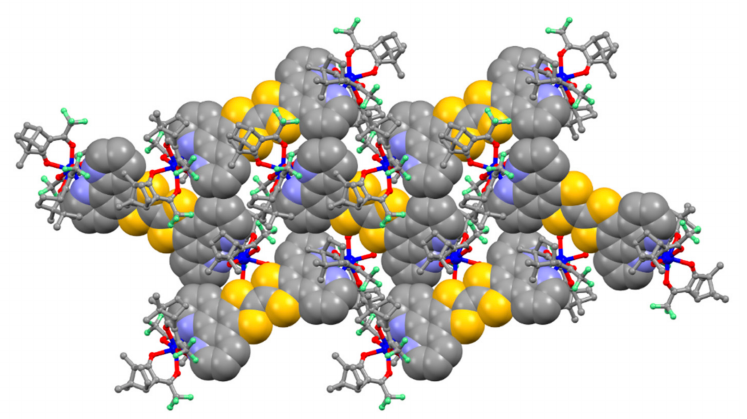
Figure 3. Crystal packing of ( 2 ) · 2(C 6 H 14 ) with the triads L and Dy(facam) 3 units drawn respectively in spacefill and ball and sticks